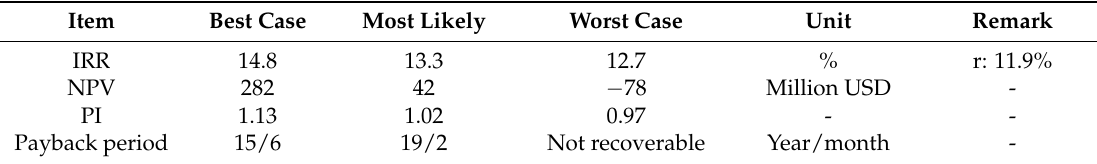
Table 11. Tolling model economic evaluation for virtual Project A.